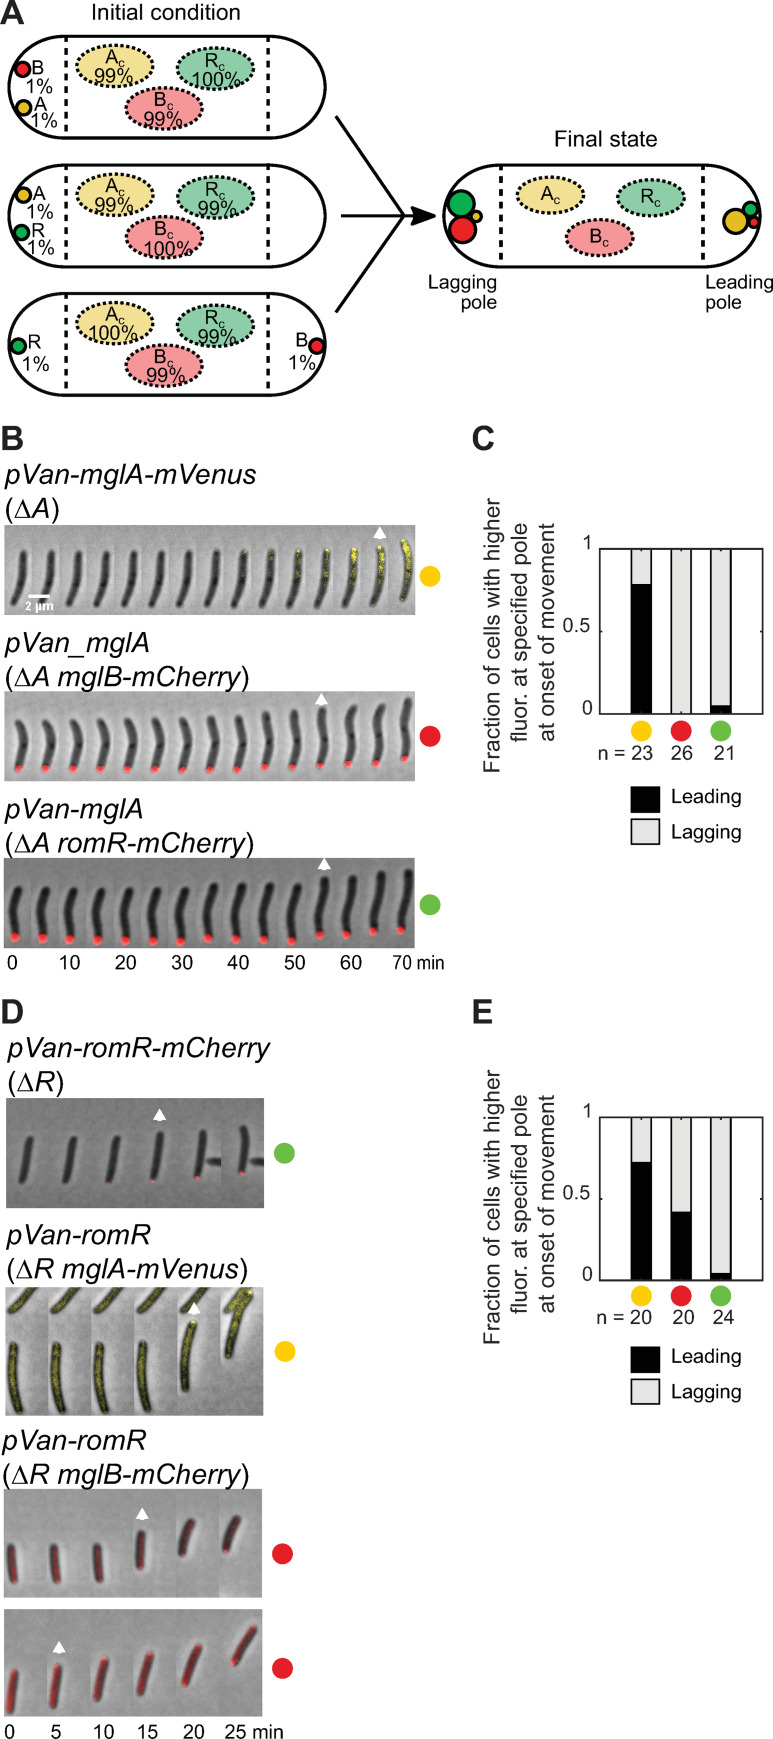
Exploring the dynamic establishment of polarity at the onset of movement.A. Polarity establishment based on the mathematical model. Simulated cells were initialized with polar asymmetry (1%) of two proteins, as indicated (left). For each of the initial arrangements shown, the system evolves to the same final state (right). In particular, if RomR and MglB are initially at opposite poles, the pole with RomR becomes the future lagging pole. B. Localization of MglB-mCherry (top), RomR-mCherry (middle) and MglA-mVenus (bottom) at the onset of movement during induction of mglA (top, middle) or mglA-mVenus (bottom) with 300 μM vanillate for the indicated period of time. White arrow indicates onset of movement. Scale bar, 2 μm. C. Fraction of cells in B in which the brighter MglA-mVenus (yellow), MglB-mCherry (red) and RomR-mCherry (green) polar clusters were at the indicated pole at the onset of movement. MglA-mVenus, MglB-mCherry and RomR-mCherry were all significantly biased (two-sided binomial tests, p = 0.011, p = 3×10−8 and p = 2×10−5) towards the leading, lagging and lagging poles, respectively. n, number of cells analyzed. D. Localization of RomR-mCherry (top), MgA-mVenus (middle) and MglB-mCherry (bottom) at the onset of movement during induction of romR-mCherry (top) or romR (middle, bottom) with 300 μM vanillate for the indicated period of time. White arrow indicates onset of movement. E. Fraction of cells in D in which the brighter MglA-mVenus (yellow), MglB-mCherry (red) and RomR-mCherry (green) polar clusters were at the indicated pole at the onset of movement. MglA-mVenus and RomR-mCherry were significantly biased (two-sided binomial tests, p = 0.041 and p = 3×10−6) towards the leading and lagging pole, respectively, while MglB-mCherry did not show a leading/lagging pole bias (two-sided binomial test, p = 0.82). n, number of cells analyzed.